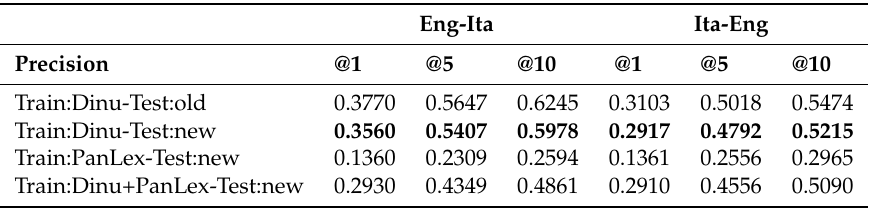
Table 9. Comparing Dinu’s and PanLex data on Dinu’s test set.